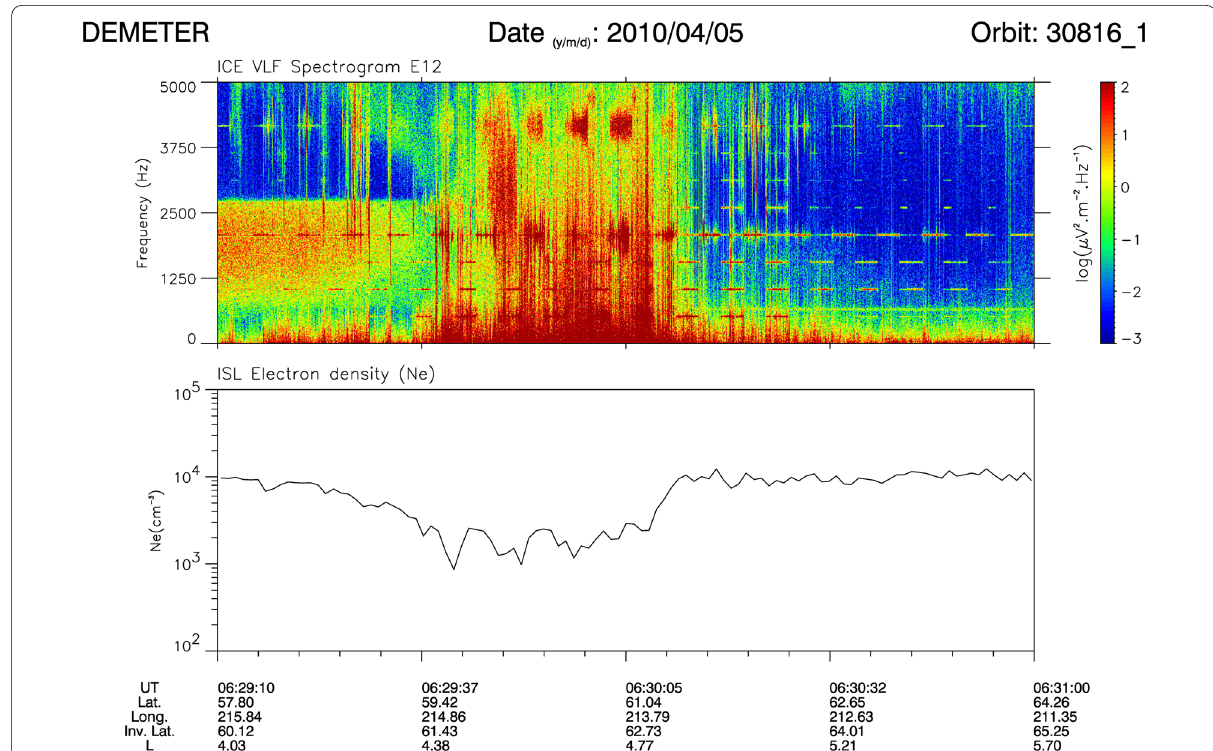
Fig. 28 Case 6: data recorded on April 5, 2010 between 06:29:10 UT and 06:31:00 UT. The top panel presents a spectrogram of an electric field component between 0 and 5 kHz. Its intensity is color-coded according to the scale on the right. The bottom panel presents the electron density. The parameters displayed below are the time in UT, the geographic latitude and longitude, the invariant latitude and the L